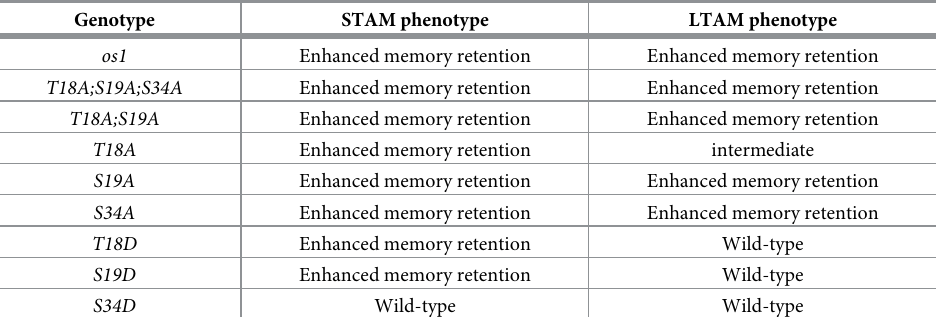
Table 1. Summary of short-term (STAM) and long-term (LTAM) memory phenotypes of the various MSI-1 phos-